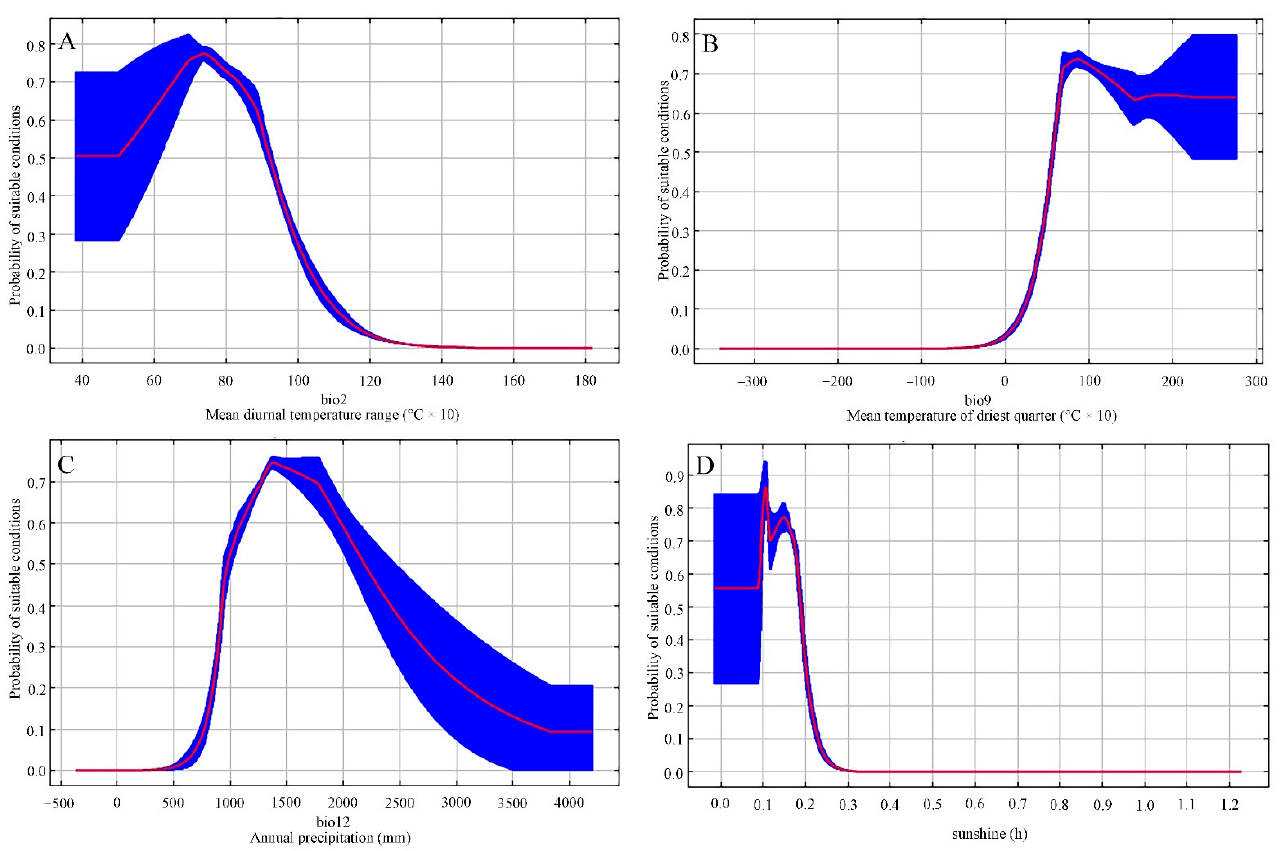
Figure 2. Response curves of important environment predictors in the species distribution model for Cinnamomum camphora : ( A ) mean diurnal temperature range, ( B ) annual precipitation, ( C ) mean air temperature of driest quarter, and ( D ) sunshine duration in growing season based on the Maxent algorithm for C. camphora in China.